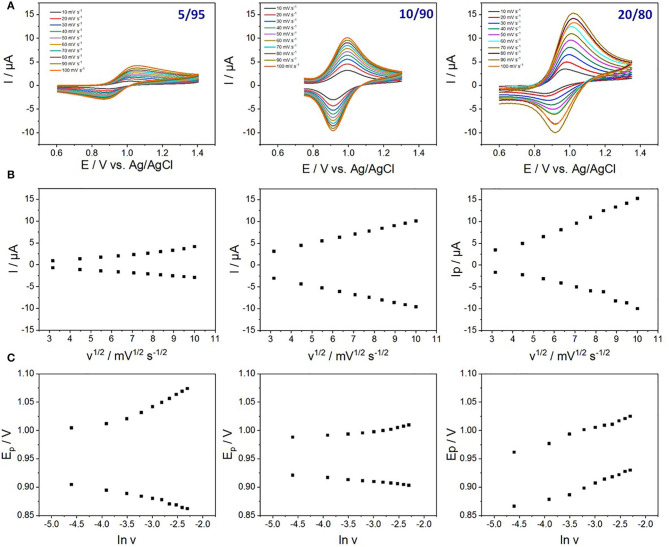
(A) Cyclic voltammograms of Fe(tpy)2-functionalized films prepared from various TEOS/AzPTES ratios (total concentration: 200 mM), as recorded at potential scan rates of 10, 20, 30, 40, 50, 60, 70, 80, 90, and 100 mV s−1, in an electrolyte solution containing 0.1 M TBABF4 in acetonitrile. (B) Dependence of the peak current on the scan rate (10–100 mV.s−1): Linear correlation between the peak current and the square root of scan rate. (C) Corresponding variations of peak potentials as a function of the logarithm of scan rate.